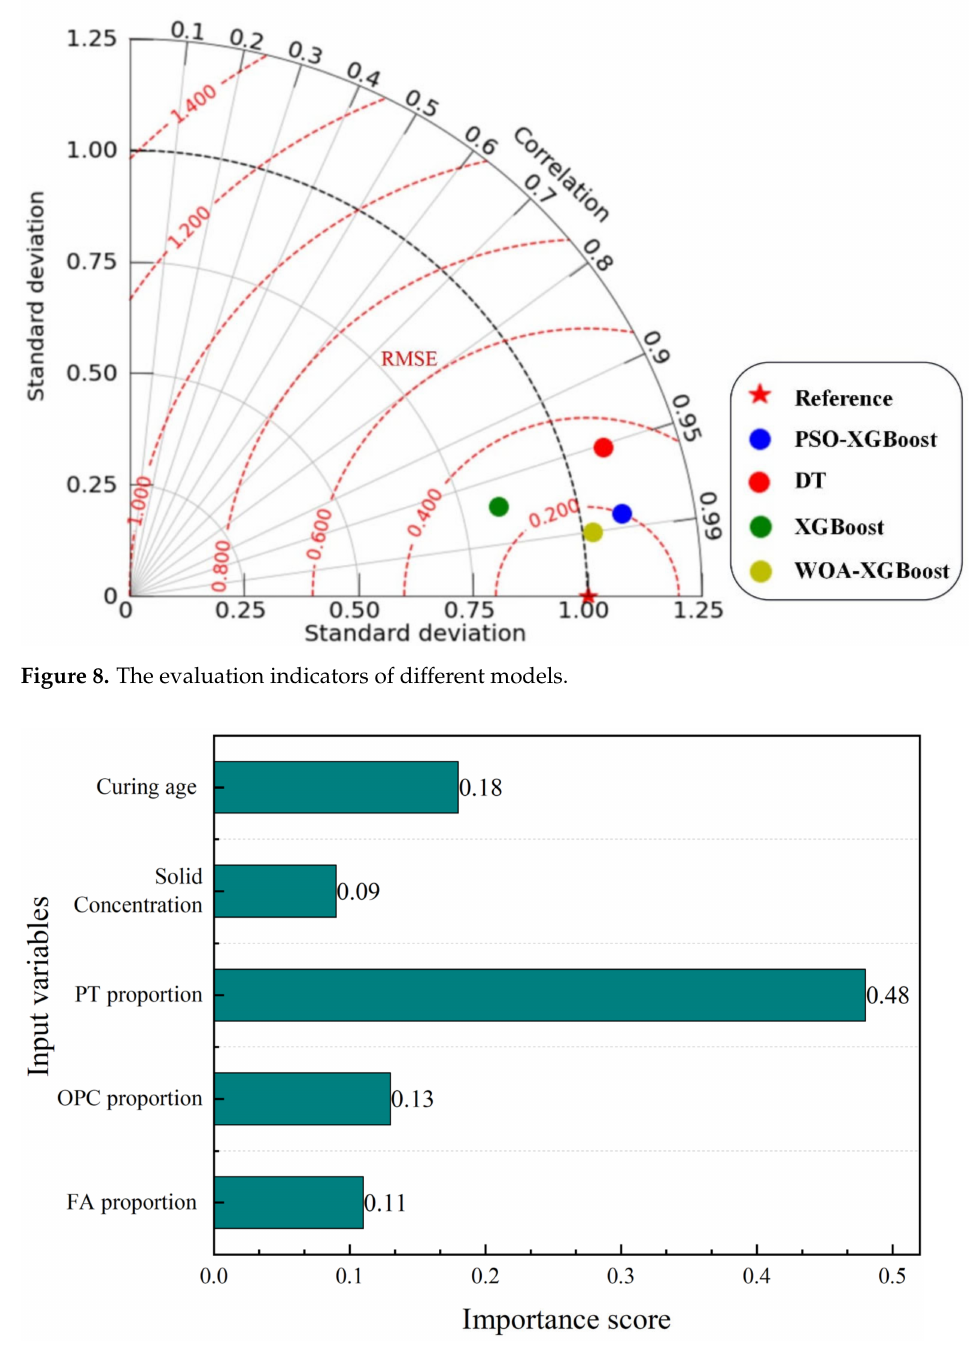
Figure 9. The importance scores of five input